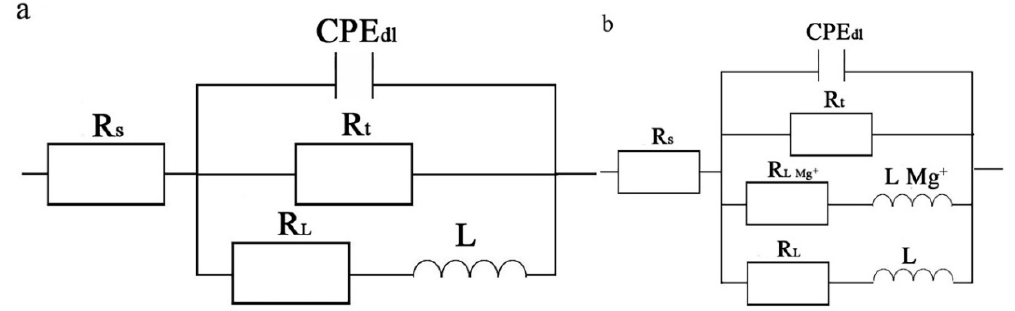
Figure 10. Equivalent circuit of Ex-AZ91-free alloy ( a ), Ex-AZ91-Y alloy ( b ). The curve of the reciprocal of polarization resistance ( R p ) 1/ R p with immersion time in Figure 11